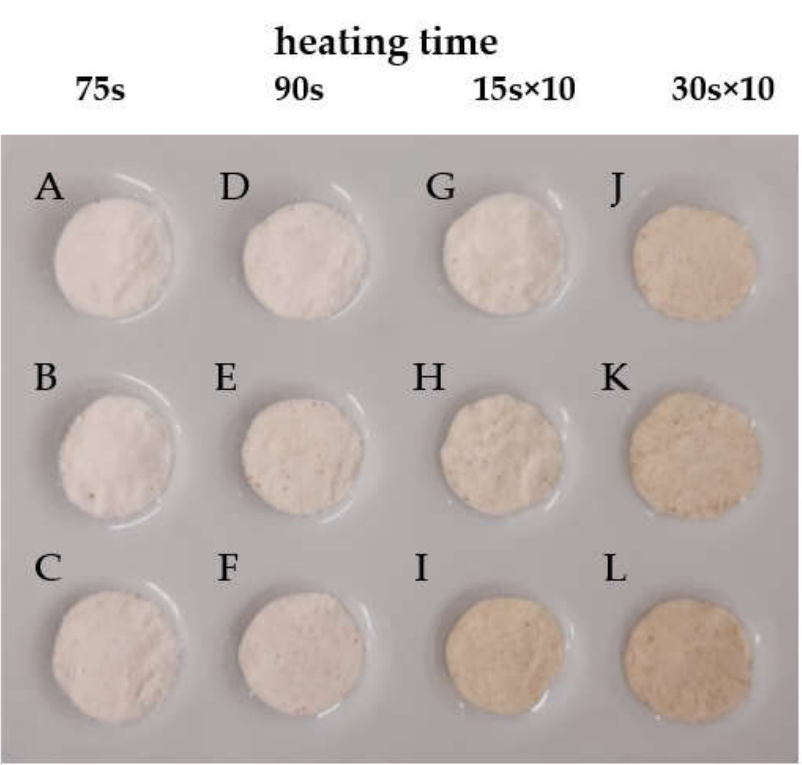
Figure 3. Appearance of dextrins obtained by microwave-assisted heating: continuous—40 W ( A , D ), 45 W ( B , E ), and 50 W ( C , F ) and discontinuous–100 W ( G , J ), 110 W ( H , K ), and 120 W ( I , L ).